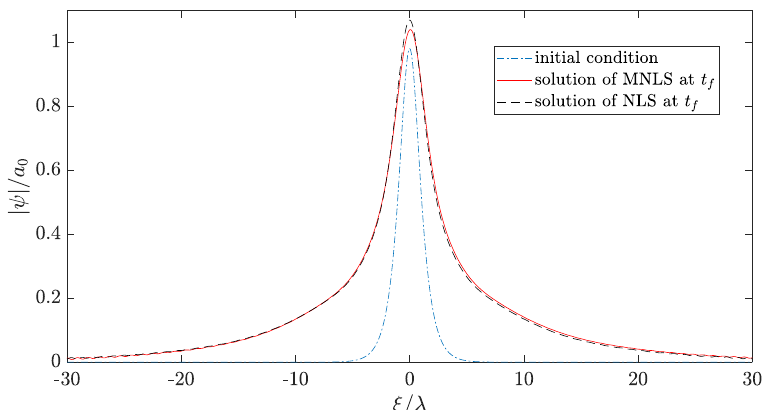
Figure 20. Comparison between the soliton solutions of the stochastic MNLS and the stochastic NLS with non-white noise excitation in time using the lab parameters and mean wind velocity V m = 4 m/s and σ v = 2 m/s.